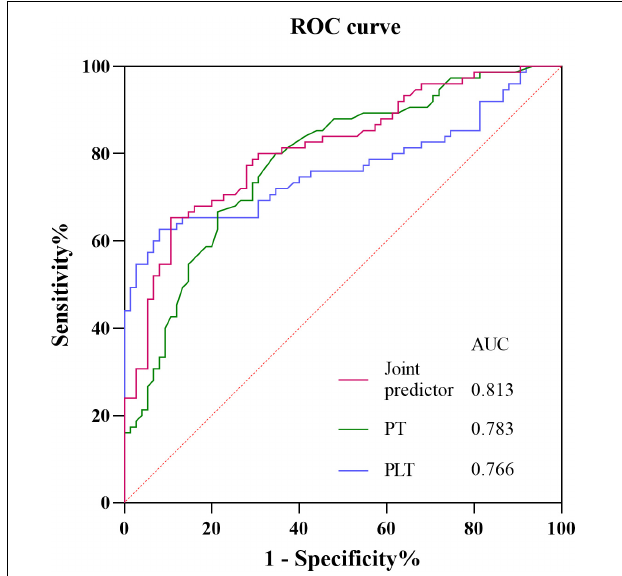
FIGURE 8 | Receiver operating characteristic curves obtained with different discriminatory models for predicting the onset of SAH in patients with active cancer. The joint predictive factor showed the largest AUC of 0.8131 (95% CI 0.745–0.881, P < 0.001). The optimum cut-off point was 11.719. At this cut-off value, the sensitivity was 65.3% and the specificity was 89.3%. CI, Confidence interval; ROC, Receiver operator characteristic; AUC, Area under the